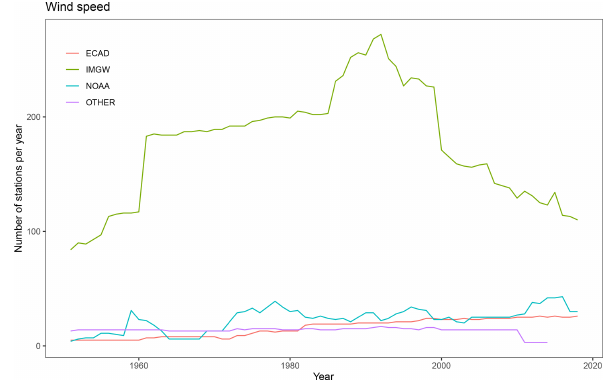
Figure 5. Number of meteorological stations for wind speed obser- vations per year from 1951 to 2019.